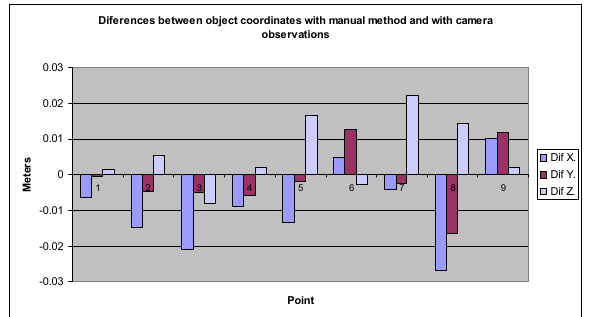
Figure 8. Differences between object coordinates in long range distance test with camera and manual method.